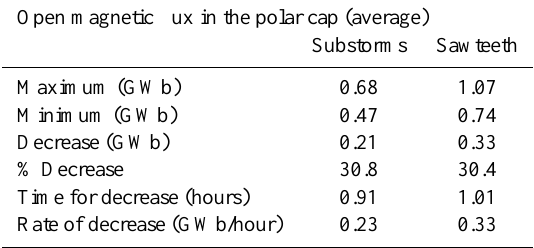
Table 1. Average polar cap open magnetic flux statistics for sub- storms and sawteeth.